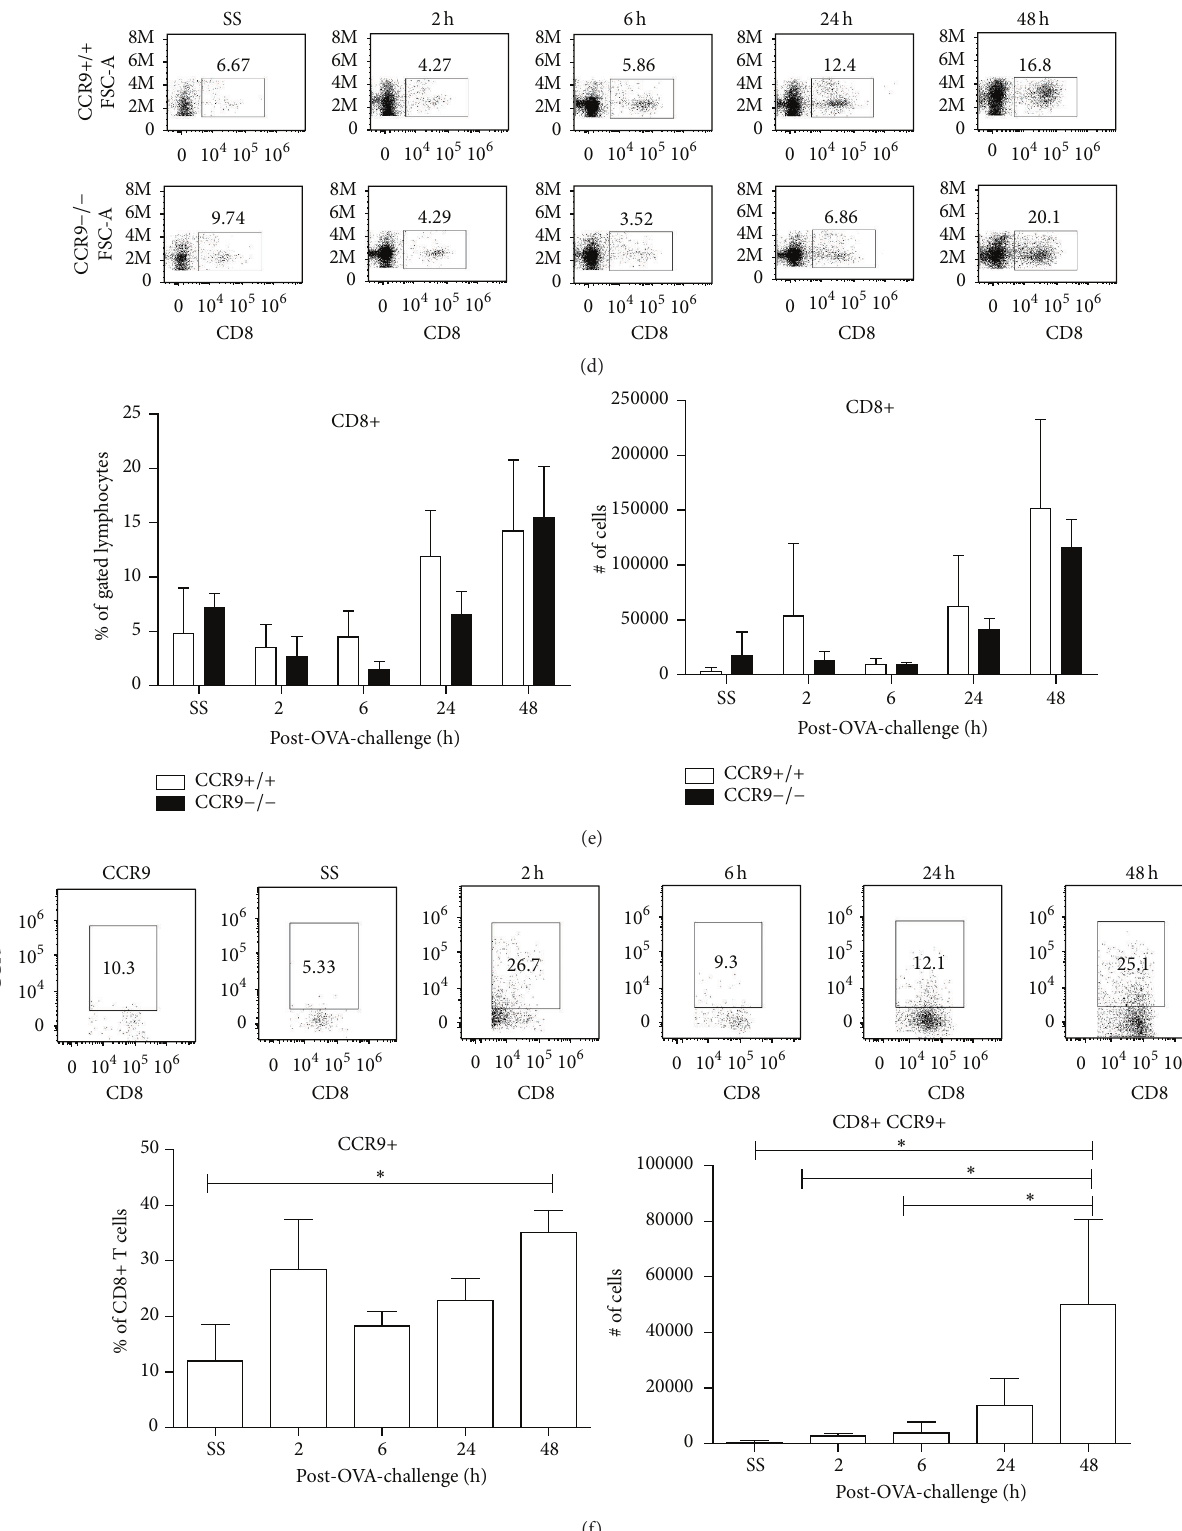
Figure 7: Lymphocyte recruitment during airway inflammation is affected in absence of CCR9. 2, 6, 24, and 48h after the last OVA-challenge, BALFfromsensitizedmicewascollectedandFACSanalysisof(a)CD4and(d)CD8T-lymphocytesisshown.PercentageofCD4+(b)andtotal number (e) of CD4+ T-lymphocytes gated in region of lymphocytes. CCR9+ cells were analyzed in (c) CD4+ or (f) CD8+ T-lymphocytes. Data are representative of 2 independent experiments and represent mean ± SD. 𝑛 = 3 –5 for each group ( ∗ 𝑝 < 0.05 , ∗∗ 𝑝 < 0.01 , and ∗∗∗ 𝑝 < 0.001 when compared with WT mice or when compared each time with control